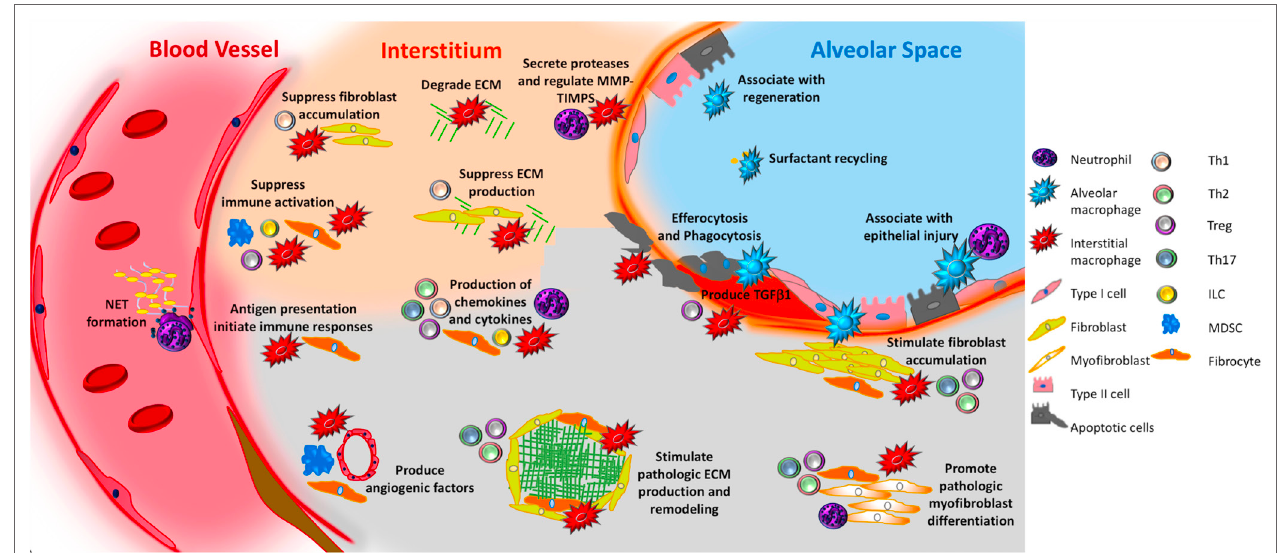
FigURe 4 | Unifying schematic of immunopathogenic mechanisms of idiopathic pulmonary fibrosis (IPF) reveals that many important fibrosis-promoting processes may be regulated by input from both the innate and adaptive immune systems. Currently available data suggest that innate mechanisms may dominate. For example, both alveolar and interstitial macrophages respond to innate immune ligands present in pathogen-associated molecular patterns or danger-associated molecular patterns to assume adopt fibrosis modifying properties, including production of TGF β 1, paracrine regulation of fibroblast accumulation and